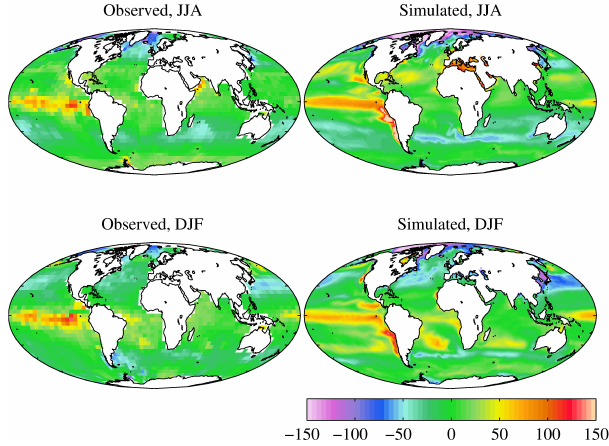
Fig. 21. Observational (Takahashi et al., 2009; left) and simulated Fig. 19. Observational (Takahashi et al., 2009; left ) and simulated ( right ) surface ∆ pCO 2 for northern summer (June– July–August; top ) and northern winter (December–January–February; bottom ). ∆ pCO 2 in ppm. (right) surface 1p CO 2 for northern summer (June-July-August; top) and northern winter (December-January-February; bottom). 1p CO 2 in ppm.